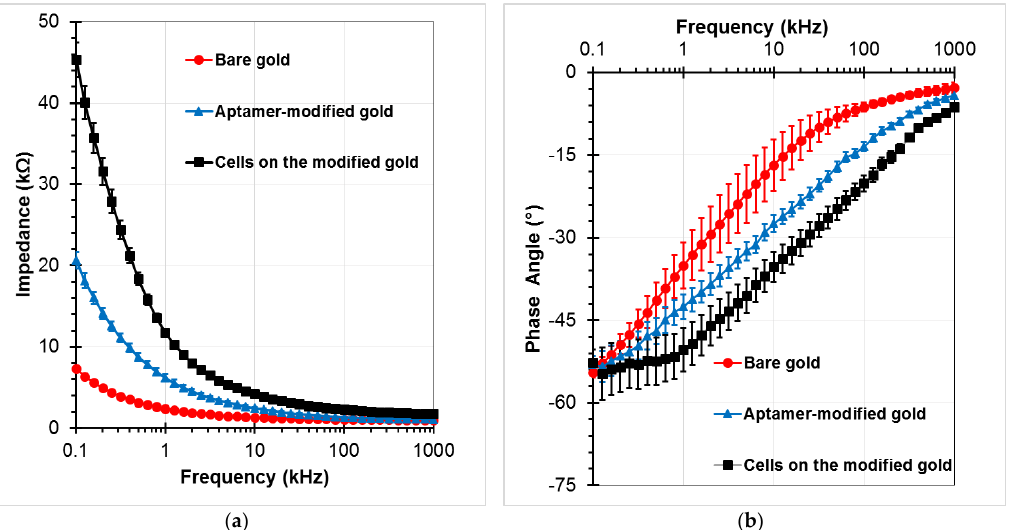
Figure 6. Impedance responses of the chip as a function of frequency for bare gold microelectrodes, aptamers-functionalized gold electrodes surface, and trapped A549 cells onto the modified electrodes with a voltage amplitude of 100 mV, and a frequency range from 100 Hz to 1 MHz: ( a ) Impedance magnitude, ( b ) Phase angle.